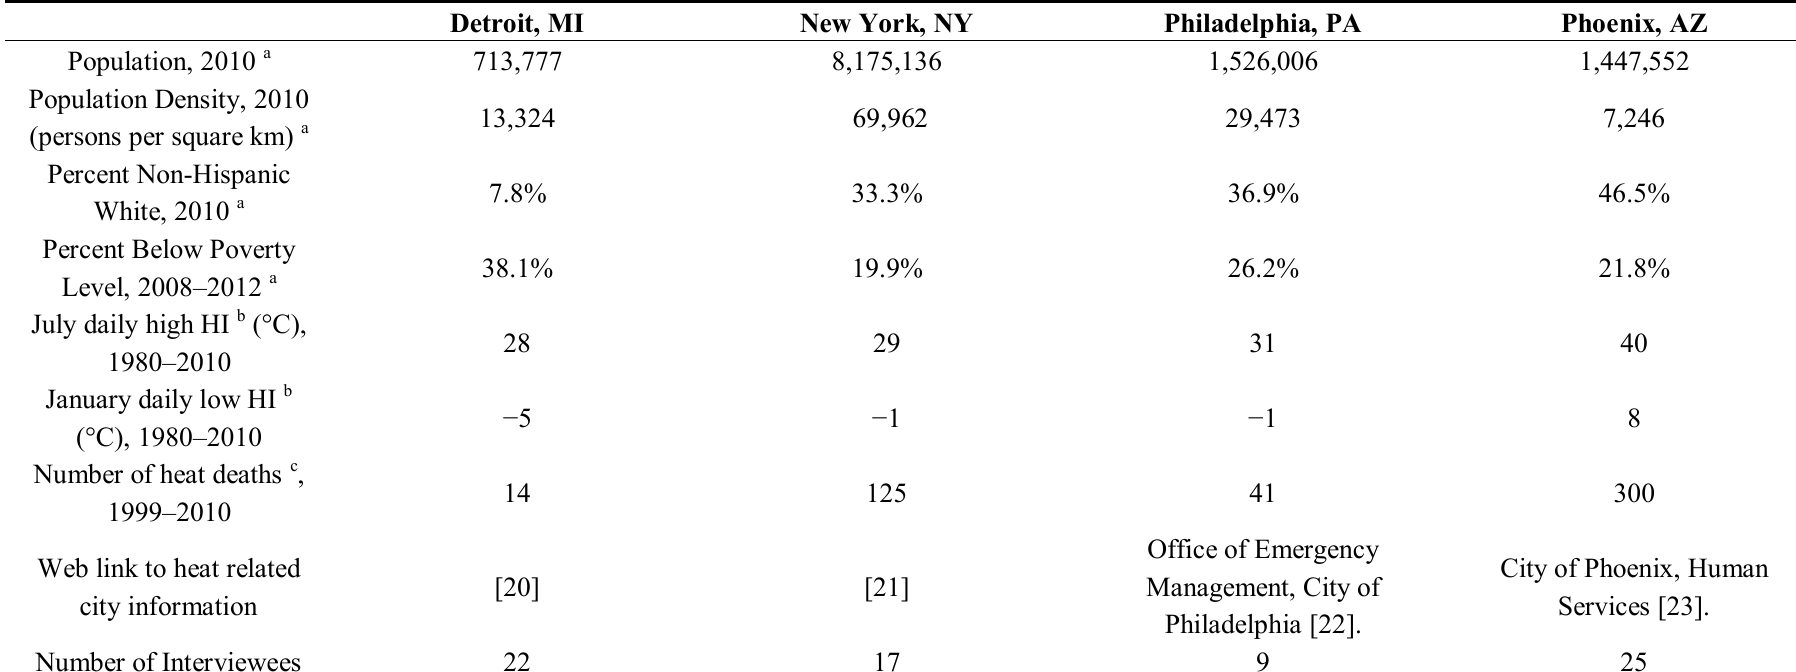
Table 1. Demographic, climatologic and epidemiologic characteristics of the study cities. Detroit,